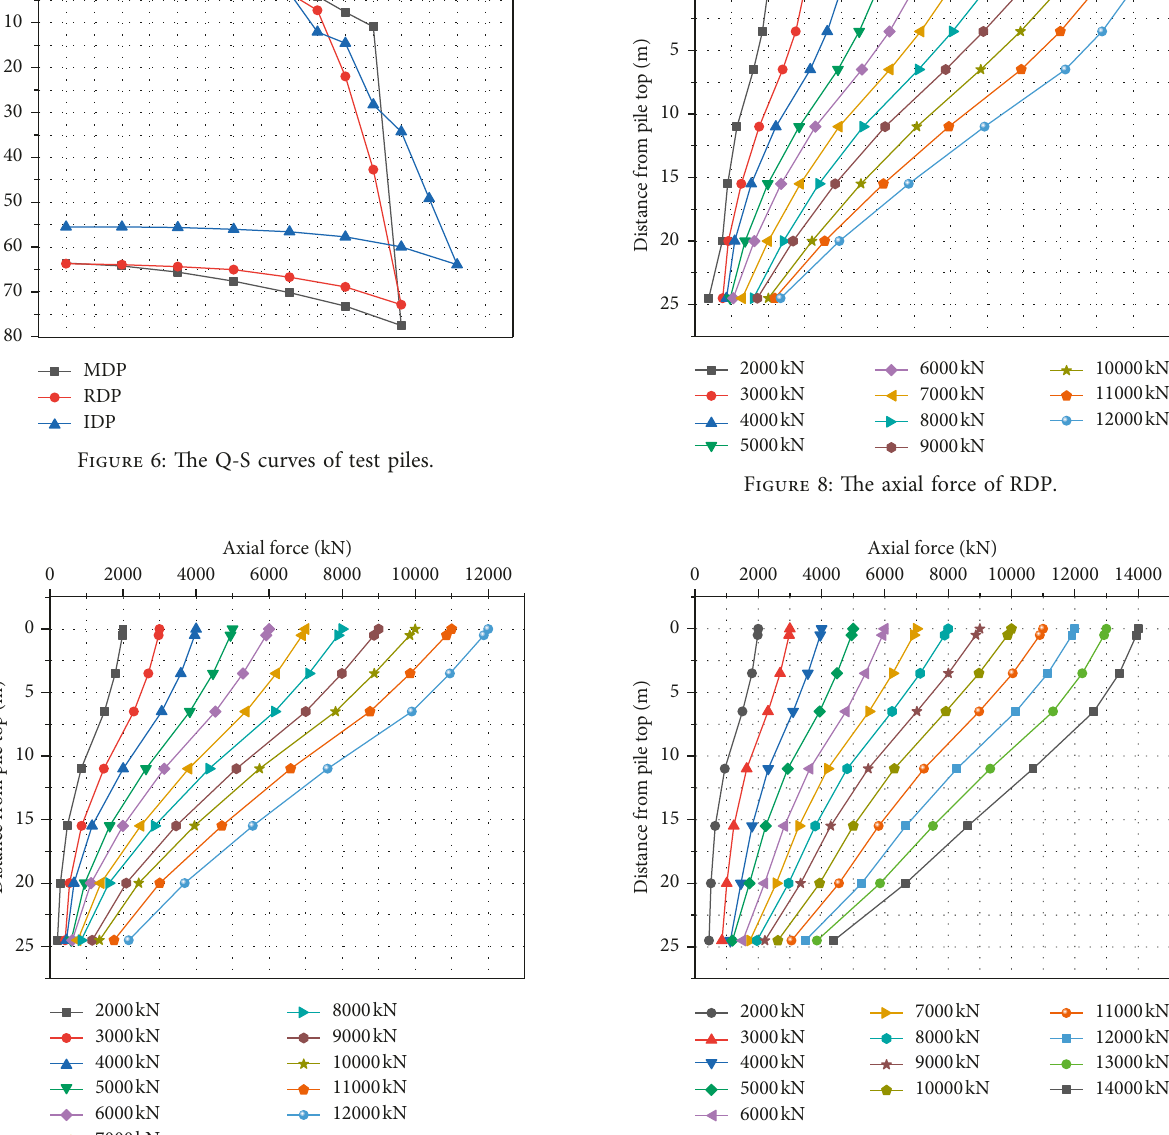
Figure 7: The axial force of